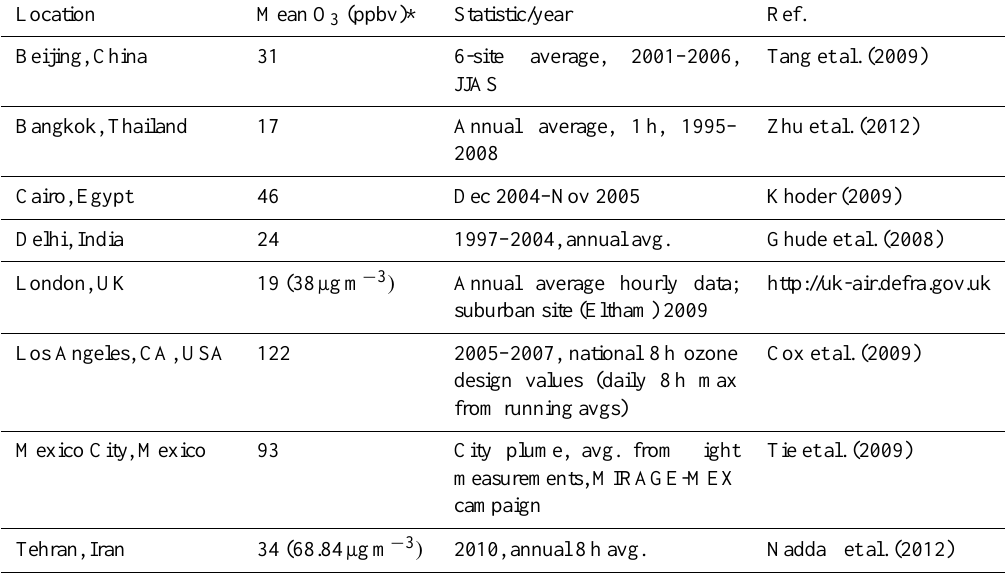
Table 2. Reported mean O 3 for